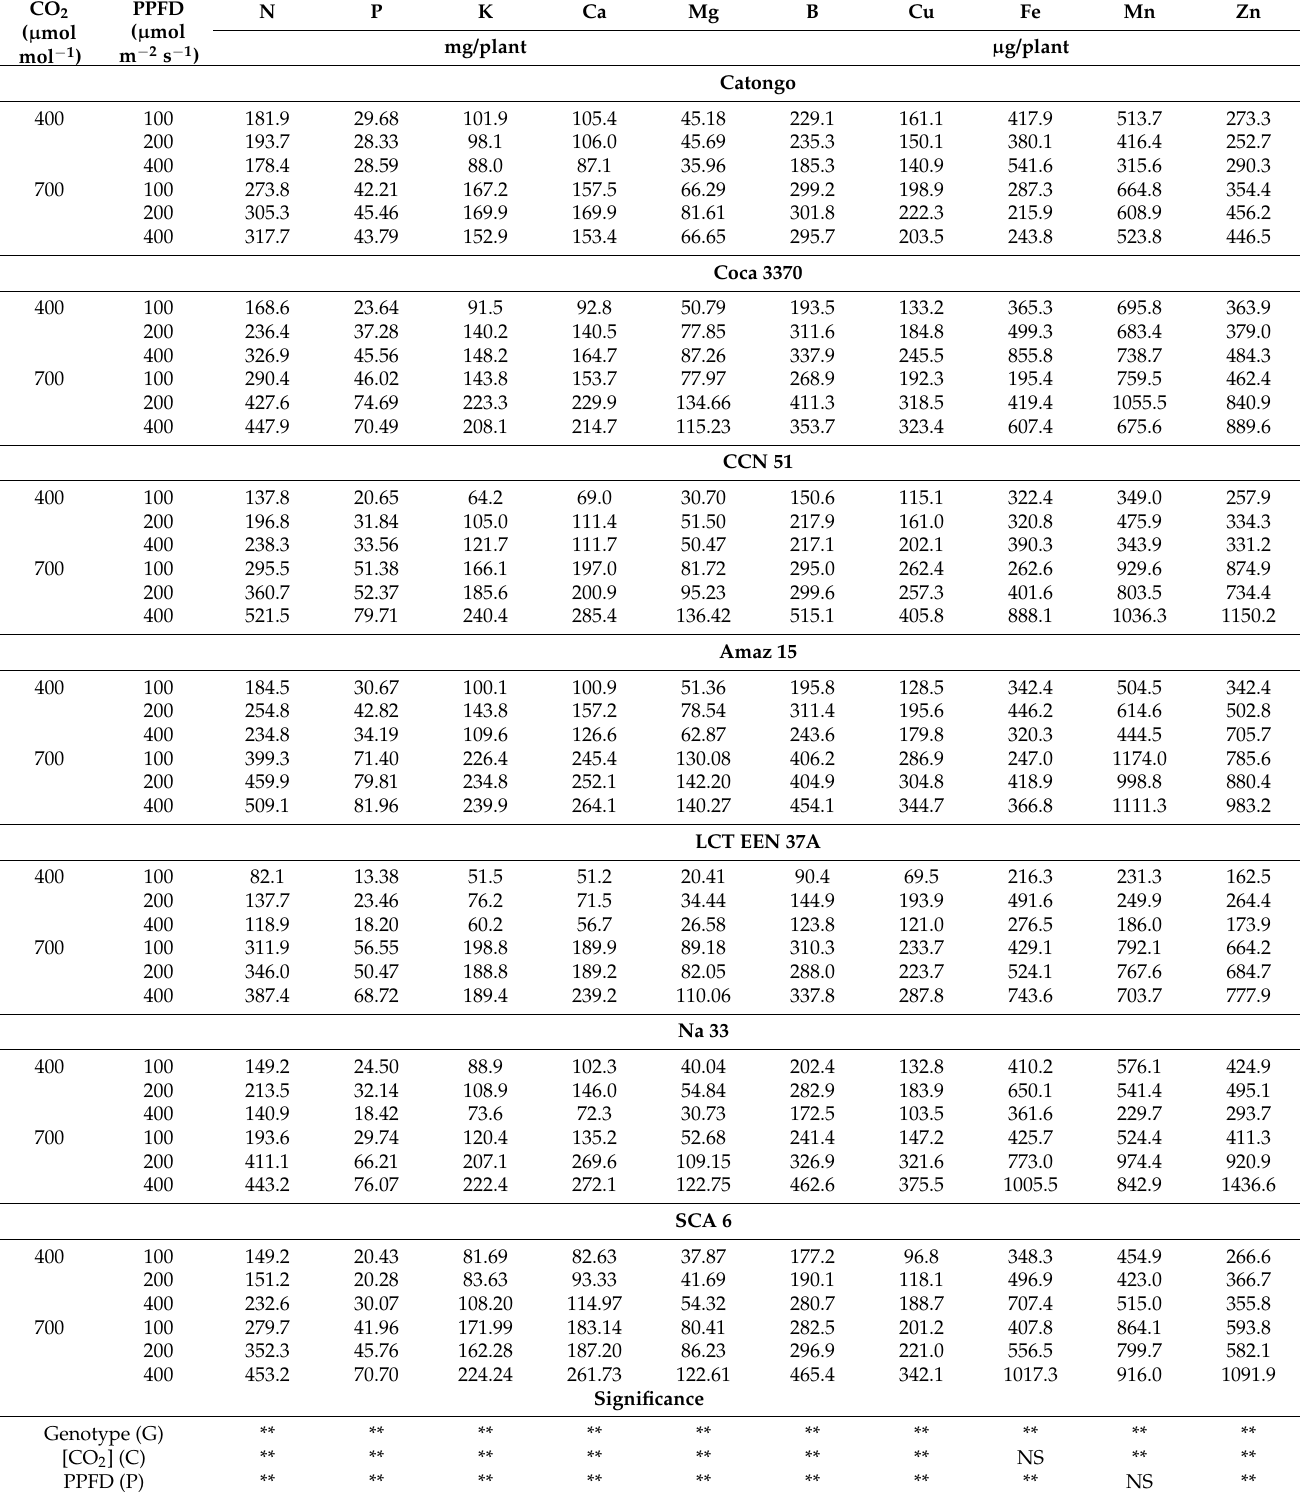
Table 4. The effect of [CO 2 ] and photosynthetic photon flux density (PPFD) on macro–micro nutrient uptake of seven cacao